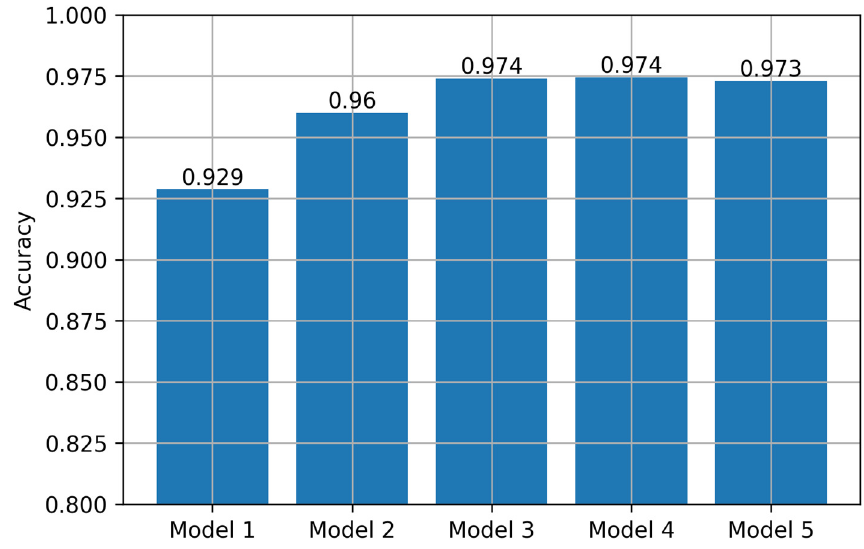
Figure 10. Accuracy of VGG16 models.